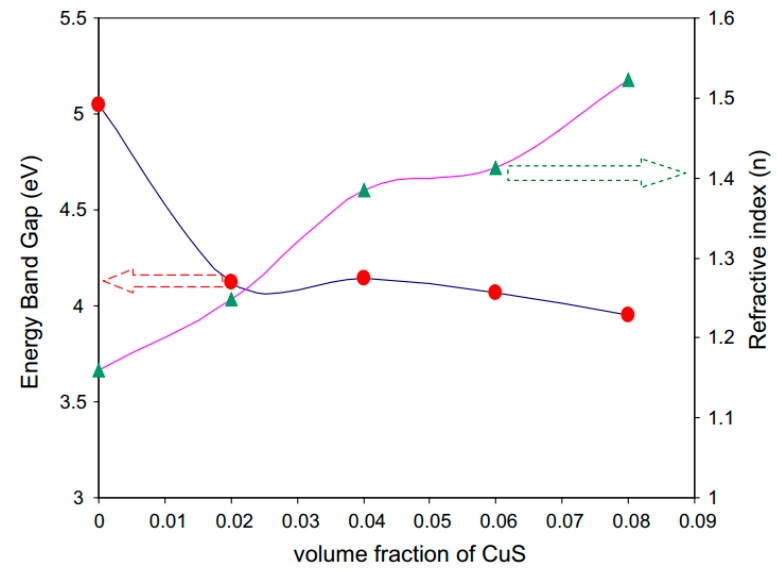
Figure 30. Energy band gap and refractive index (at 390 nm) of PMMA against CuS nanoparticles [139].